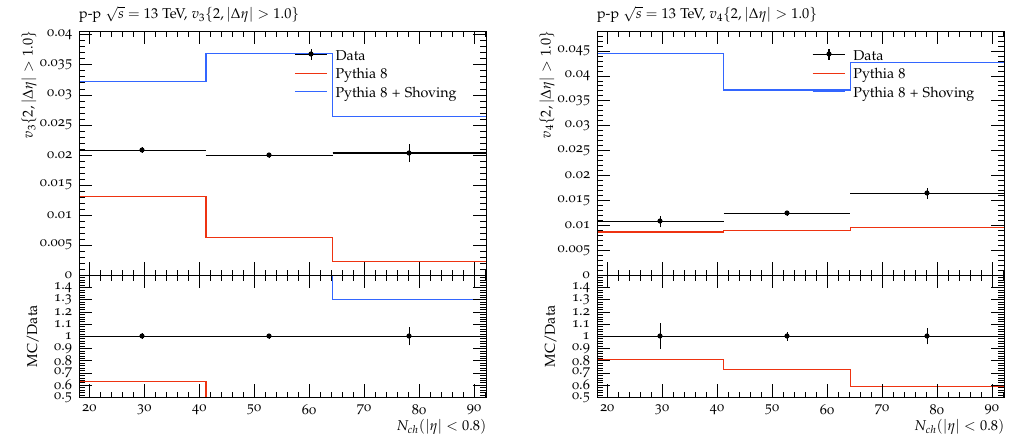
Figure 14 . Comparison to v 3 { 2 } (left) and v 4 { 2 } (right) as function of multiplicity with ALICE high multiplicity trigger. Data from pp collisions at